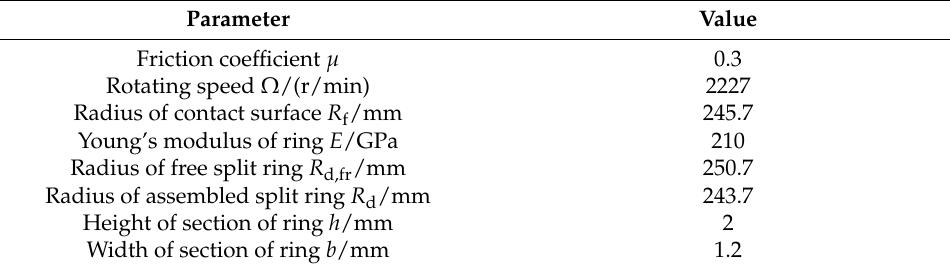
Table 4. Parameters for the labyrinth seal ‐ ring system.